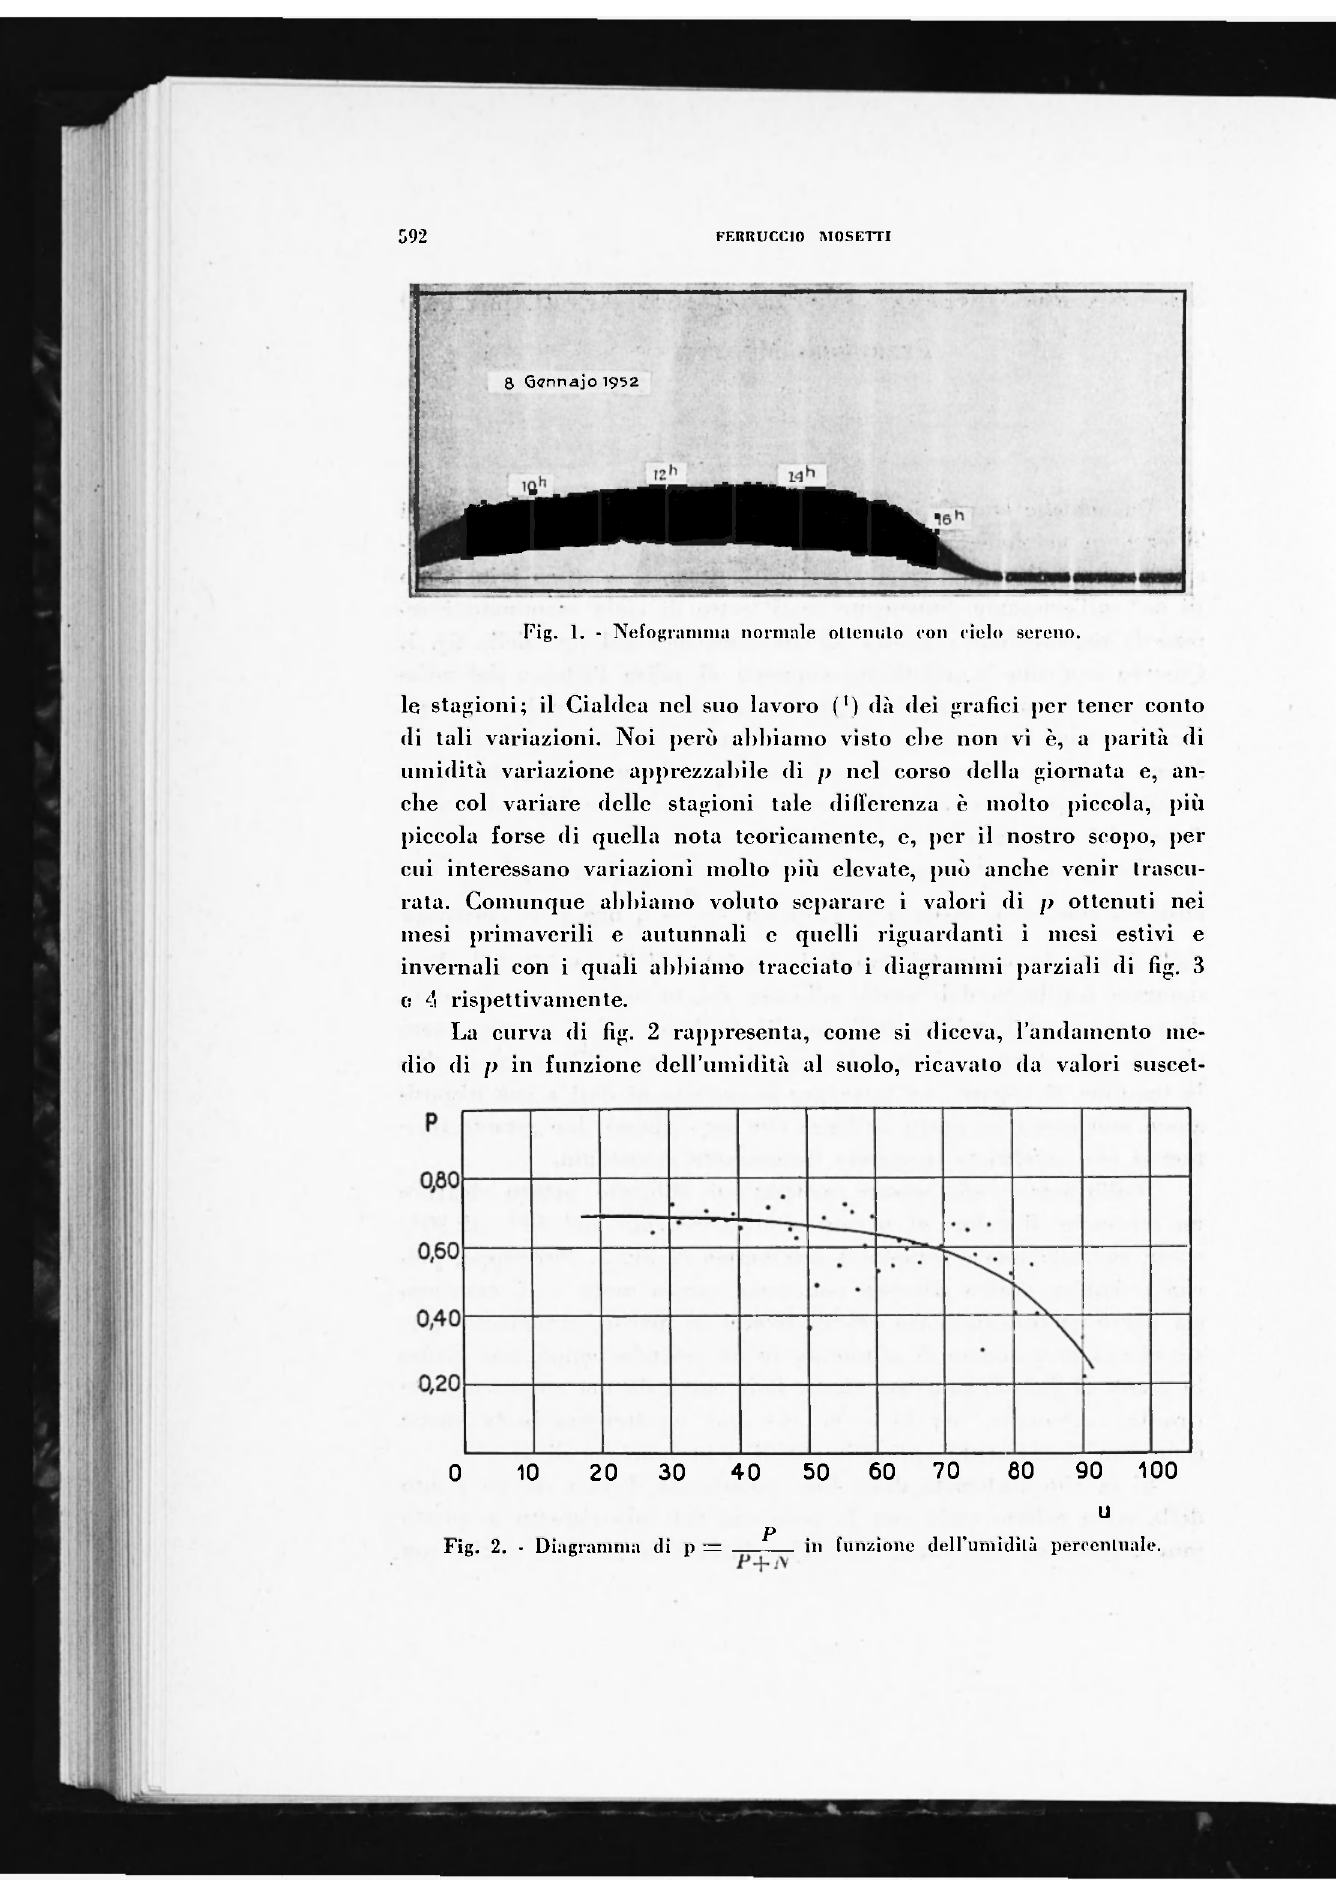
Fig. 2. - Diagramma di p =: in funzione dell'umidità percentuale.